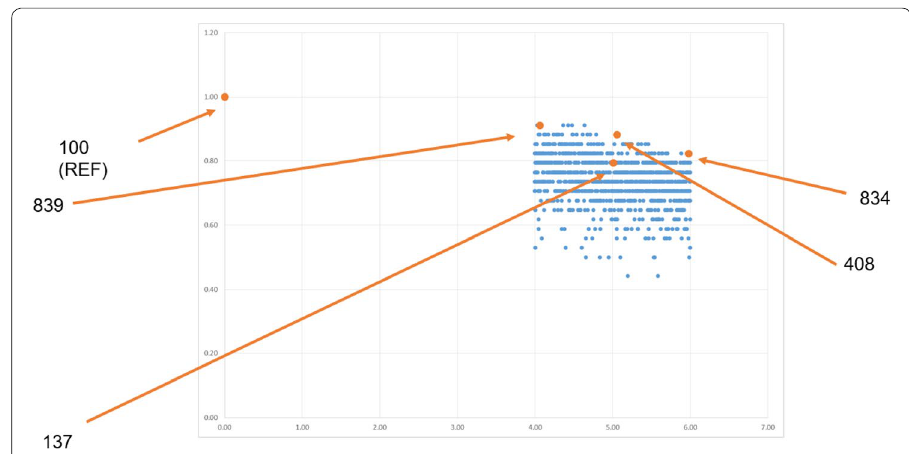
Fig. 5 The Pareto graph of the study, with the selected points in